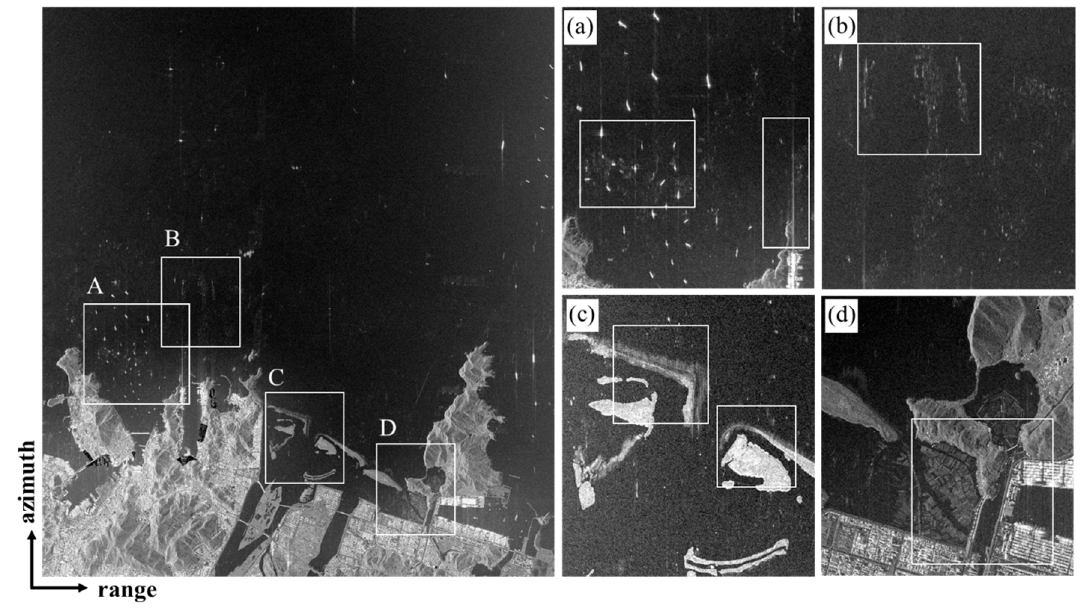
Table 1. Kompsat-5 single look complex (SLC) synthetic aperture radar (SAR) data information. HH: horizontal transmitting and horizontal receiving.